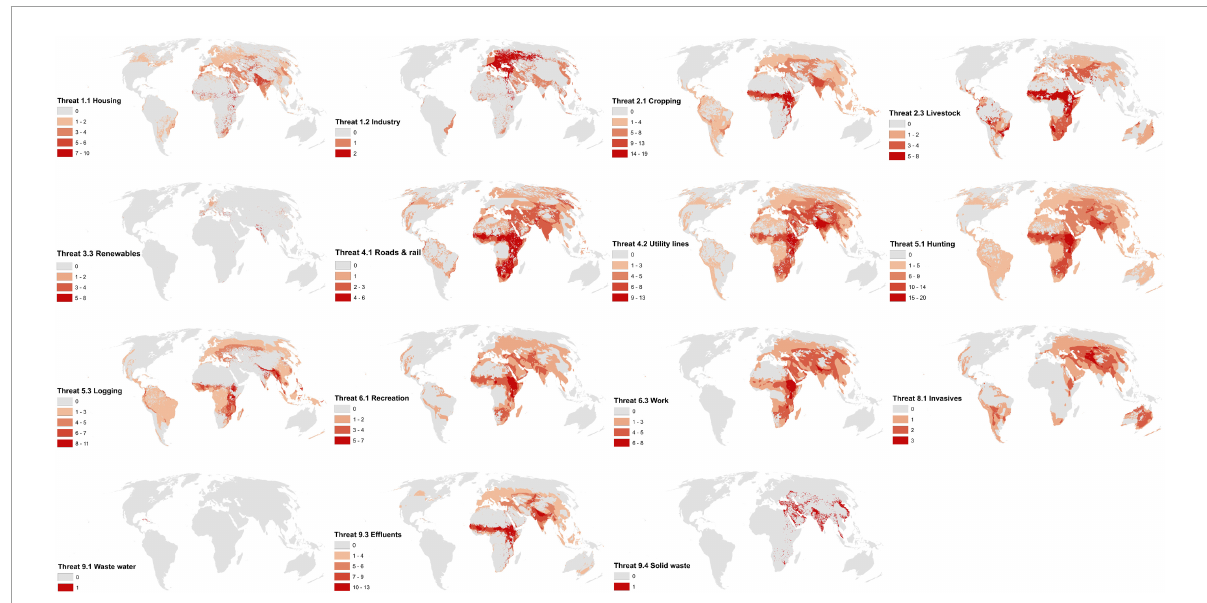
FIGURE2 Hotspots of where individual threats as listed by the International Union for Conservation of Nature (IUCN) are potentially impacting threatened raptors ( n = 172). Scales represent the number of species impacted by the threat in a grid cell. Hotspots of potential impact are in dark red. Maps use a 30 × 30 km grid and a Mollweide equal area projection. Note that some IUCN sub-class threats are mapped using the same proxy layers (e.g., IUCN sub-class threat 1.1 and 1.2 are mapped using nightlights and built environments, see Table 2 ) and that the differences in distribution for these are driven by the distribution of impacted raptors.